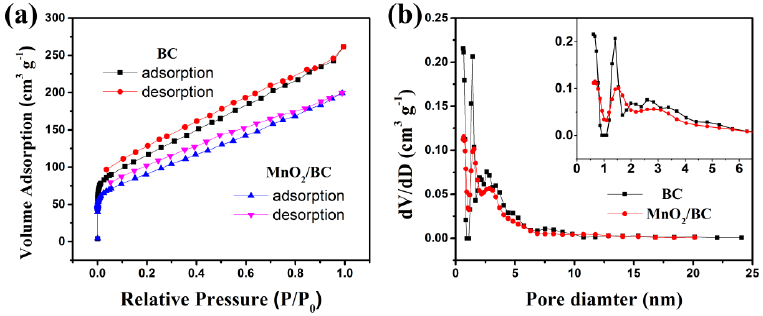
Figure 4. The XPS spectra of MnO 2 /BC hybrids: ( a ) Survey scan spectrum; ( b ) W 2p core level spectrum; ( c ) C 1s core level spectrum; ( d ) O 1s core level spectrum.